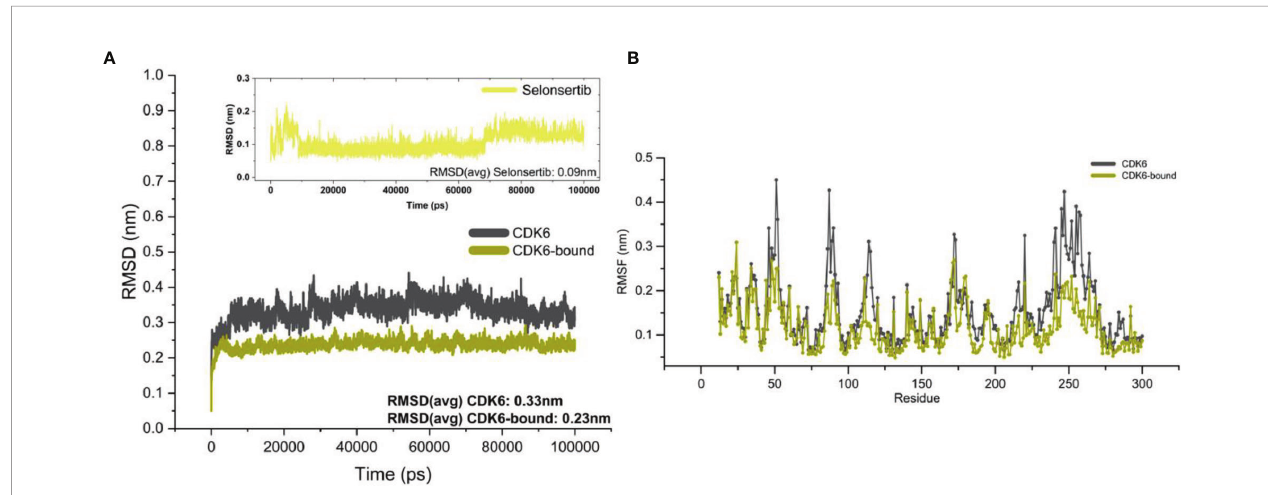
FIGURE 2 | Structural fl uctuations in the CDK6 was evaluated by MD simulation. (A) Backbone RMSD values of the unbound CDK6 protein and CDK6 protein complexed with selonsertib. The RMSD of selonsertib is shown in the inset (B) RMSF value of the unbound CDK6 protein and CDK6 protein complexed with selonsertib.